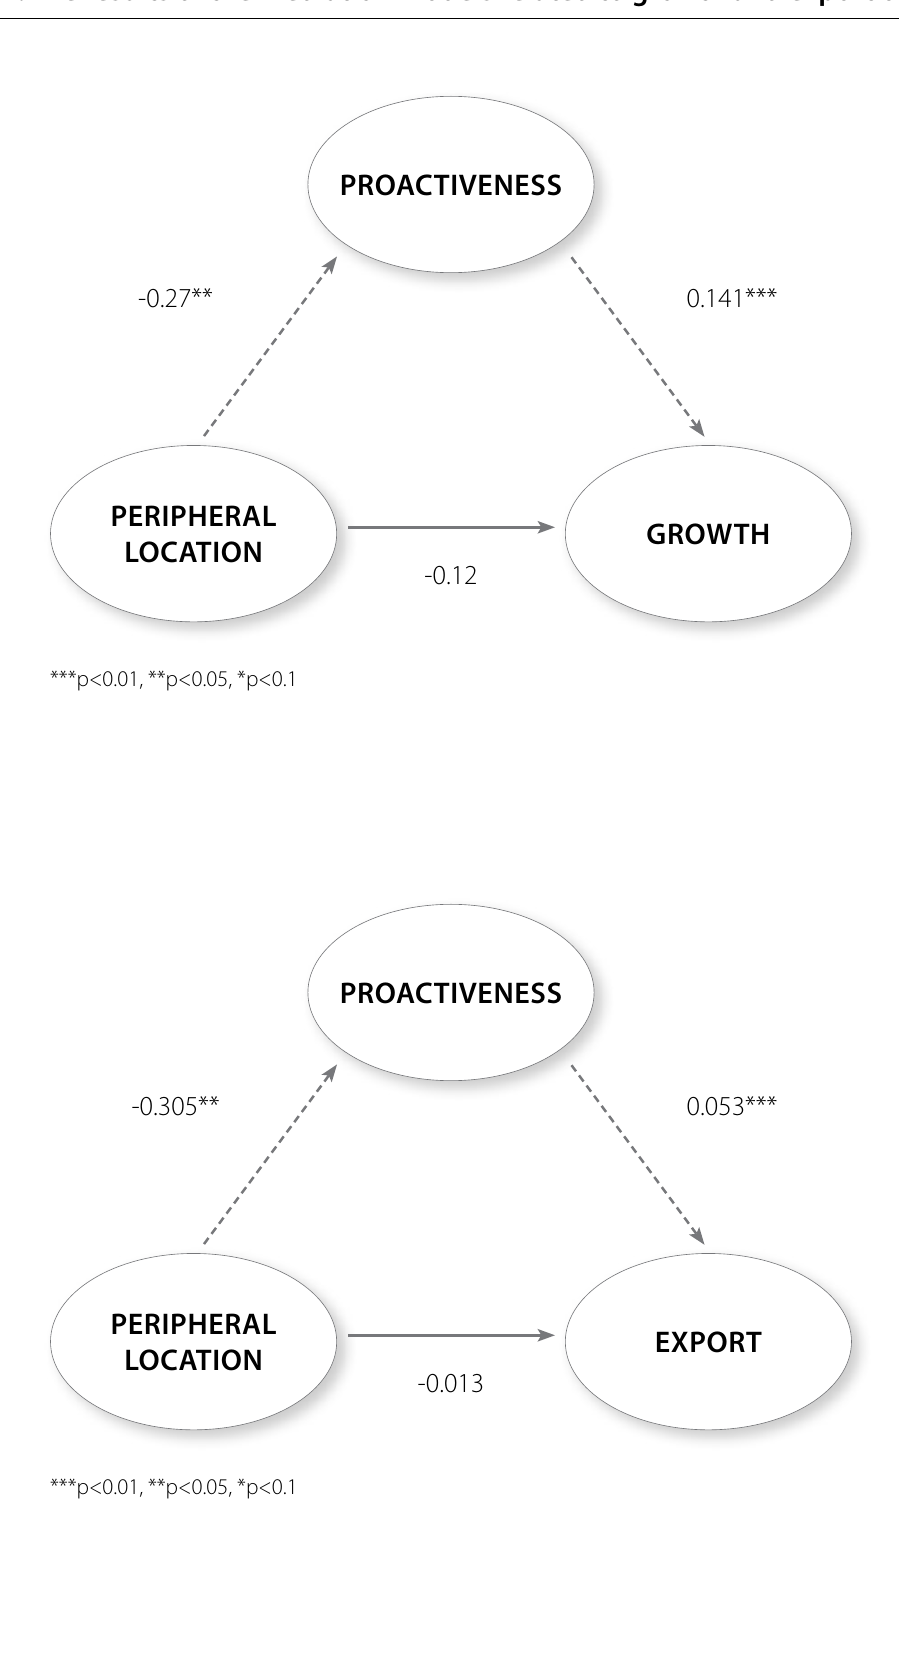
Figure 2: The results of the mediation models related to growth and export of